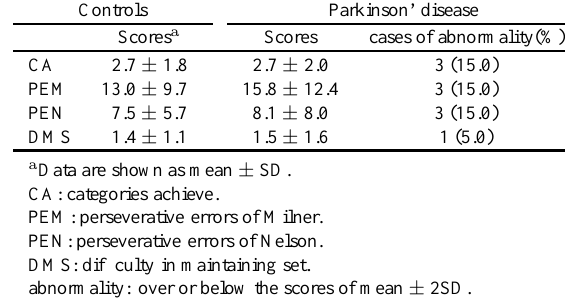
Fig. 2. P300 topographic mapping in a Parkinson ’s disease patient. The topographic mapping of 70-year-old female with Parkinson’s disease. The peak latency of P300 is within normal limits. Left map: The grand average in normal controls in their 70’s and topographic distribution of P300 is dominant at central to parietal derivations. Middle map: Topographic distribution in the patient is frontally shifted. Right map: The Z score map shows significant decrease at the parietal region. Table 2 Results of Modified Wisconsin Card Sorting Test